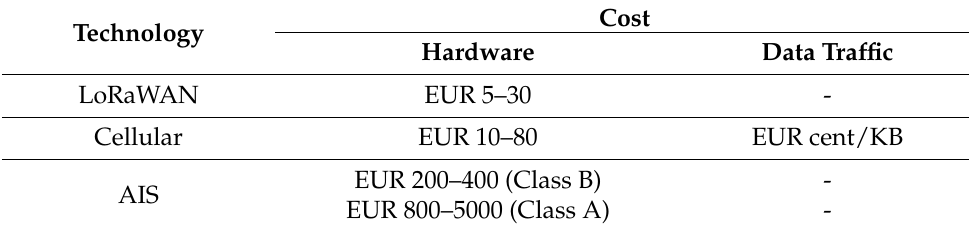
Table 3. Costs of the technological solutions